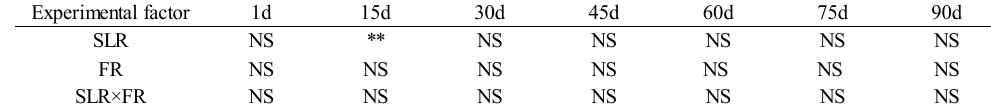
Figure 9. Effects of SLR and FR on soil TK content. Note: Bars represent means ± standard deviation ( n = 3) with different letters indicating significant differences based on LSD ( p ≤ 0.05). SLR, sugarcane leaf return; FR, fertilizer reduction.